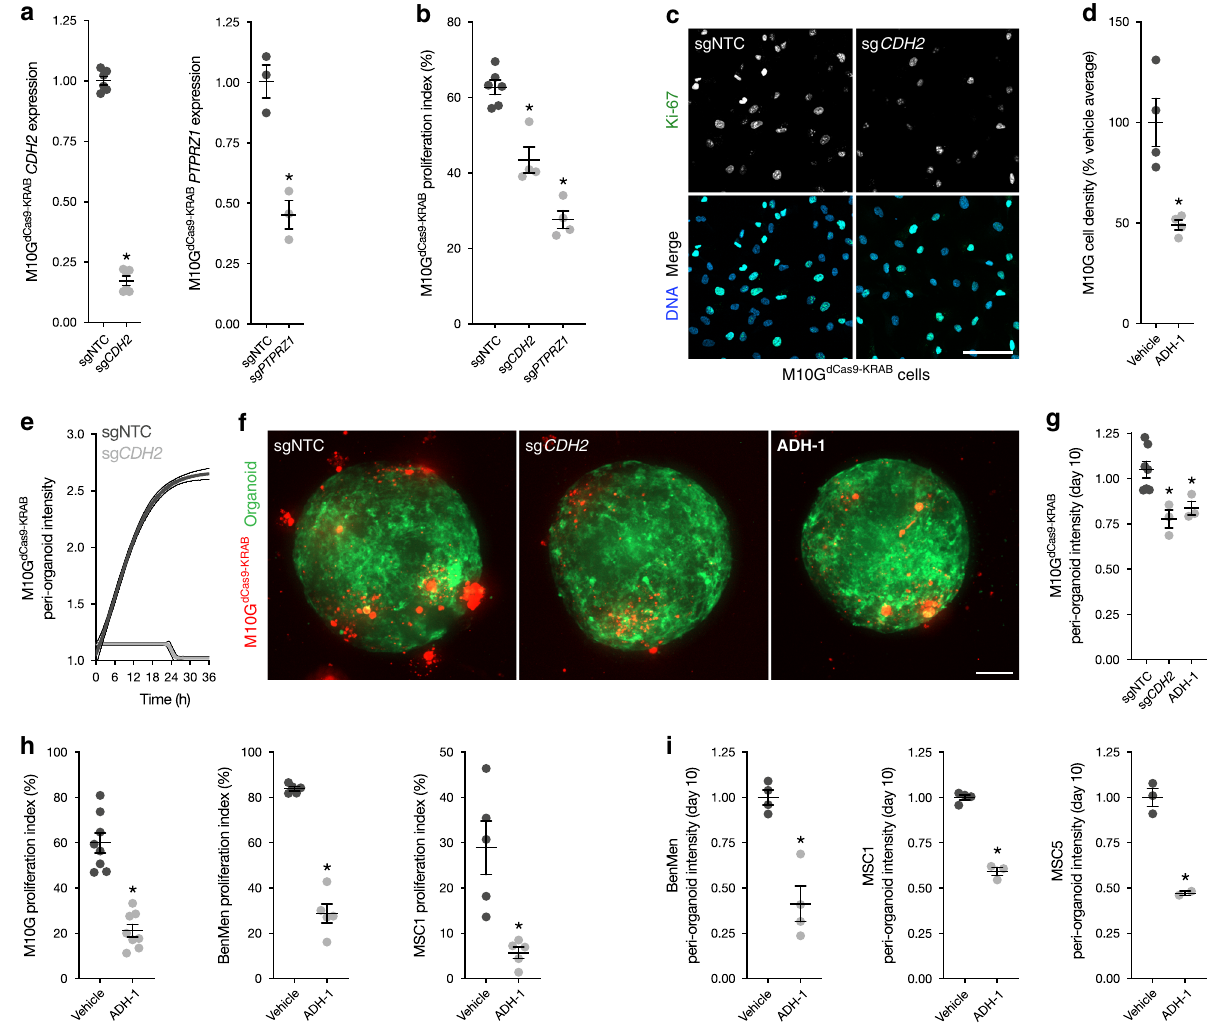
Fig. 6 CDH2 and PTPRZ1 drive meningioma cell proliferation and tumorigenesis. a qRT-PCR assessment of CDH2 and PTPRZ1 expression in M10G dCas9-KRAB meningioma cells after transduction of sgRNAs targeting these genes demonstrates repression of each gene relative to cells transduced with non-targeted control sgRNAs (sgNTC). b , c Immuno fl uorescence of Ki-67 (green) in M10G dCas9-KRAB meningioma cells after transduction sgRNAs shows that repression of CDH2 and PTPRZ1 blocks meningioma cell proliferation. DNA is marked with Hoeschst (blue). Scale bar, 100 μ m. d Treatment of M10G cells with the CDH2 antagonist ADH-1 0.2mg/ml for 48h blocks meningioma cell proliferation. e Live confocal microscopy of M10G dCas9-KRAB meningioma cells in coculture with human cerebral organoids demonstrates that transduction of sg CDH2 blocks meningioma tumorigenesis compared to transduction of sgNTC. f , g Quanti fi cation of M10G dCas9-KRAB (red) intensity in coculture with human cerebral organoids (green) after 10 days shows that transduction of sg CDH2 and treatment with ADH-1 0.2mg/ml blocks meningioma tumorigenesis. Scale bar, 100 μ m. h Immuno fl uorescence of Ki67 in M10G, BenMen, and MSC1 meningioma cells shows that pharmacologic inhibition of CDH2 with ADH-1 0.2mg/ml blocks meningioma cell proliferation. i Quanti fi cation of BenMen, MSC1, and MSC5 intensity in coculture with human cerebral organoids after 10 days shows that treatment with ADH-1 0.2mg/ml blocks meningioma